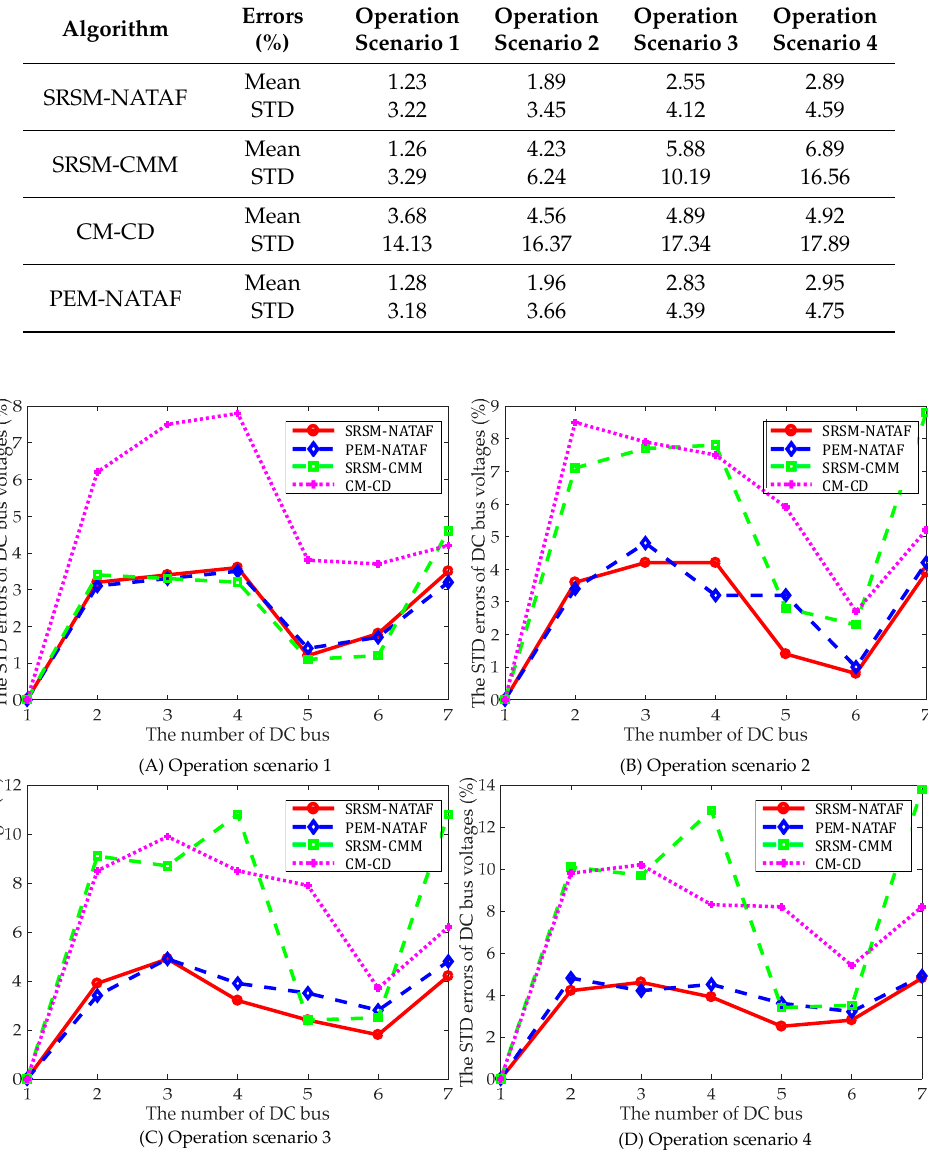
Figure 3. The standard deviation (STD) errors of the DC bus voltages in the four different operational scenarios.